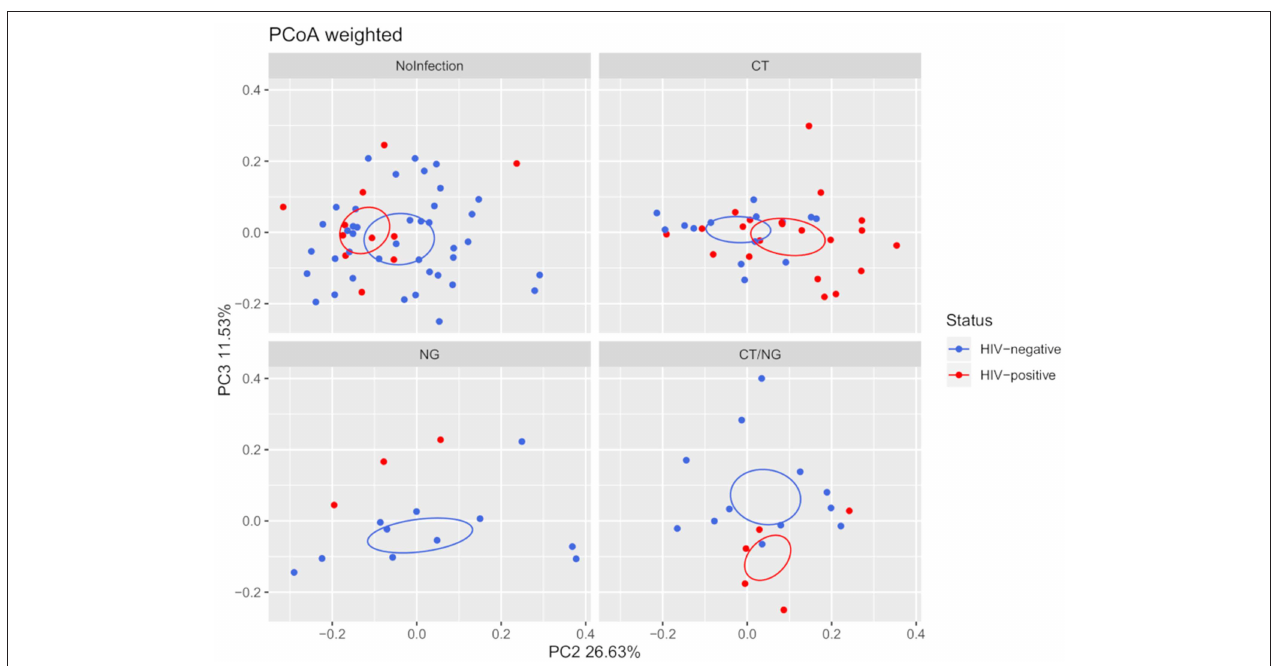
FIGURE 2 | Principal Coordinates Analysis (PCoA) plot regarding HIV infection per group, based on weighted Unifrac distance (beta-diversity). For the HIV-status of each experimental group, a SEM-based confidence ellipse is depicted. The second and third principal coordinates are represented.